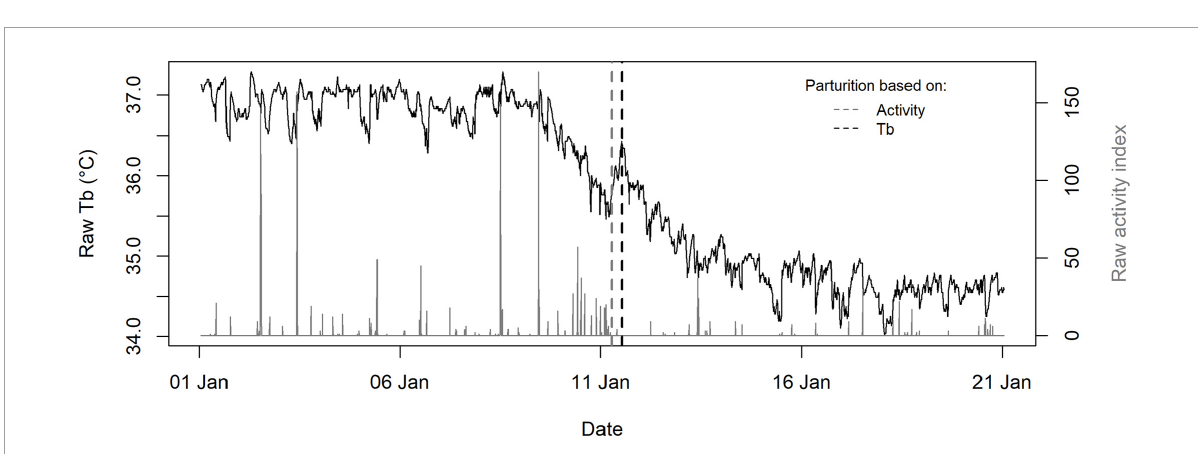
FIGURE2 Example of the raw body temperature (T b , ◦ C, recorded every 30 min, black line) and activity (recorded every 5 min, gray line) profiles of a pregnant adult female Scandinavian brown bear from the southern area in January, and associated calculated parturition date and time (vertical dashed lines). Based on the T b profile, parturition was defined as a change-point visually associated with a T b surge during the downward phase (vertical black dashed line). Based on the activity profile, parturition was defined as a change-point visually associated with a drop in the